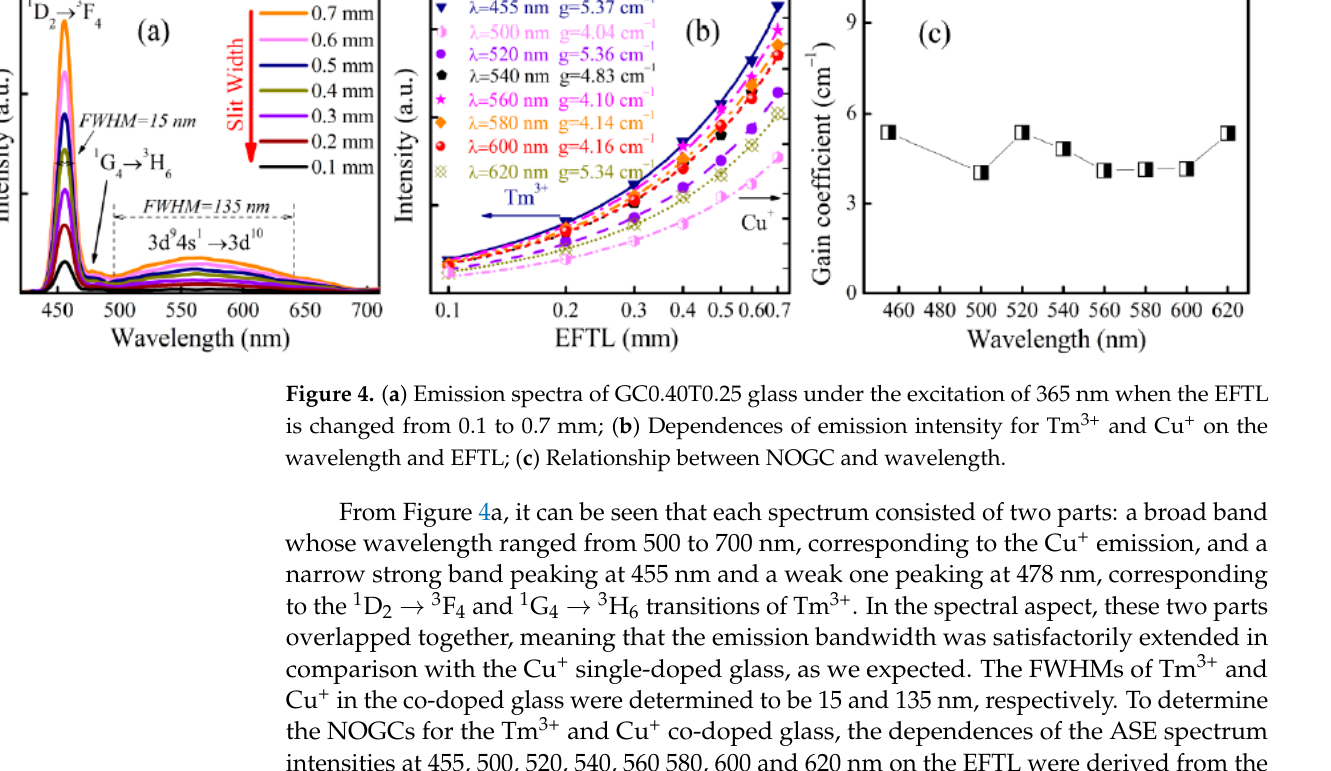
Figure 4. ( a ) Emission spectra of GC0.40T0.25 glass under the excitation of 365 nm when the EFTL is changed from 0.1 to 0.7 mm; ( b ) Dependences of emission intensity for Tm 3+ and Cu + on the wavelength and EFTL; ( c ) Relationship between NOGC and wavelength.